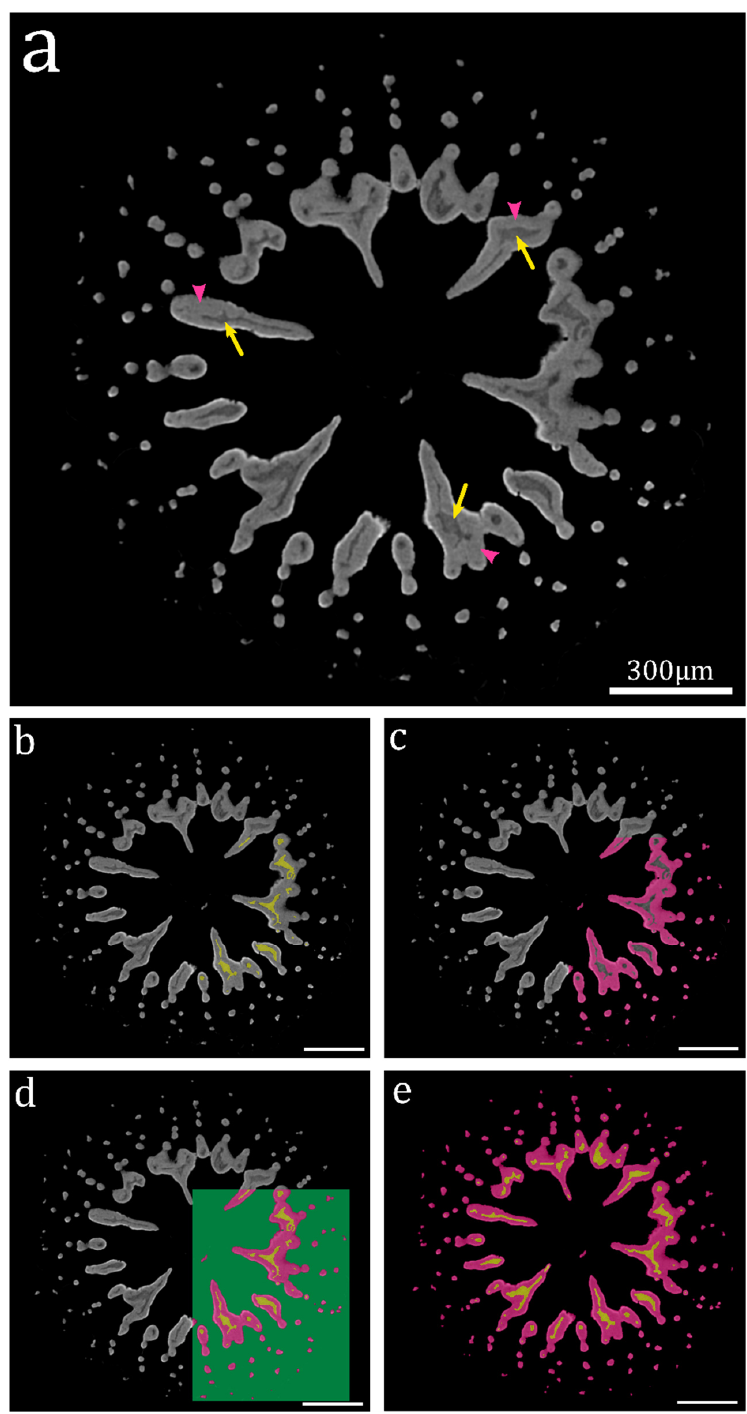
Figure 3. Overview of the DL (deep-learning-based) image segmentation process. ( a ) Example tomographic cross-sectional slices across the skeleton of a primary polyp before segmentation, revealing RADs (dark gray areas, yellow arrows) enclosed within TDs (light gray areas, pink arrowheads). ( b , c ) Manually delineated RADs ( b ; marked in yellow) and TDs ( c ; marked in pink) defined in a confined region within the training dataset. ( d ) Complete region manually delineated as training dataset, showing all three features (RADs in yellow, TDs in pink, and air spaces in green). ( e ) Result of the complete dataset processed by automatic DL-based segmentation. The AI network was applied to all slices within the stack, and it has automatically successfully distinguished RADs (yellow) and TDs (pink). Scale bars: 300 µ